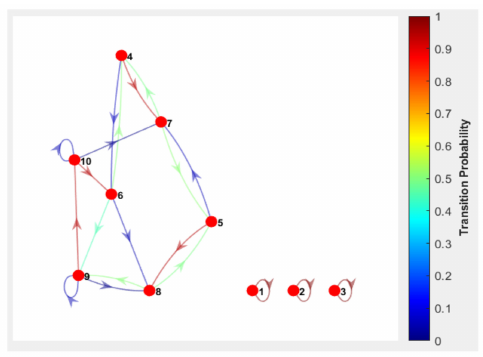
Figure 9. Example of product sequence prediction using a Markov